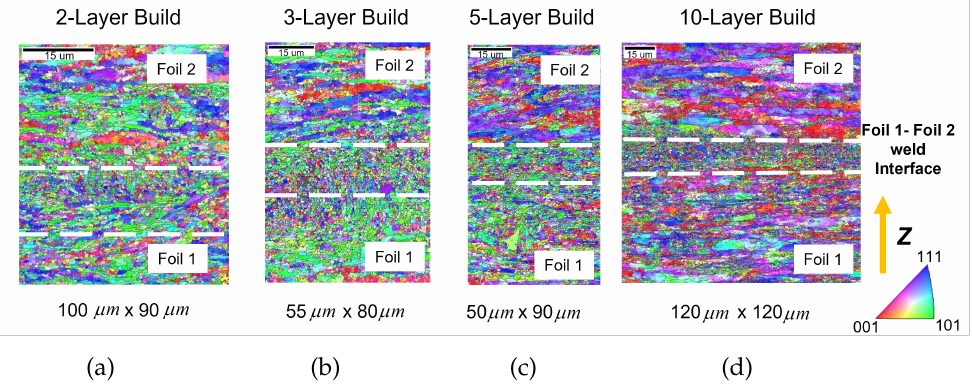
Figure 7. Inverse pole figures of ( a ) 2-, ( b ) 3-, ( c ) 5-, and ( d ) 10-layer Al 6061-H18 welds constructed on a 12.7 mm (0.5 inch) thick Al 6061-T6 baseplate using the following weld parameters: 32 µ m welder amplitude, 5000 N weld force and 84.67 mm/s (200 in/min) weld speed. The centerpoint of the interface was identified from Figure 3, and the approximate weld interface region is shown using white dashed